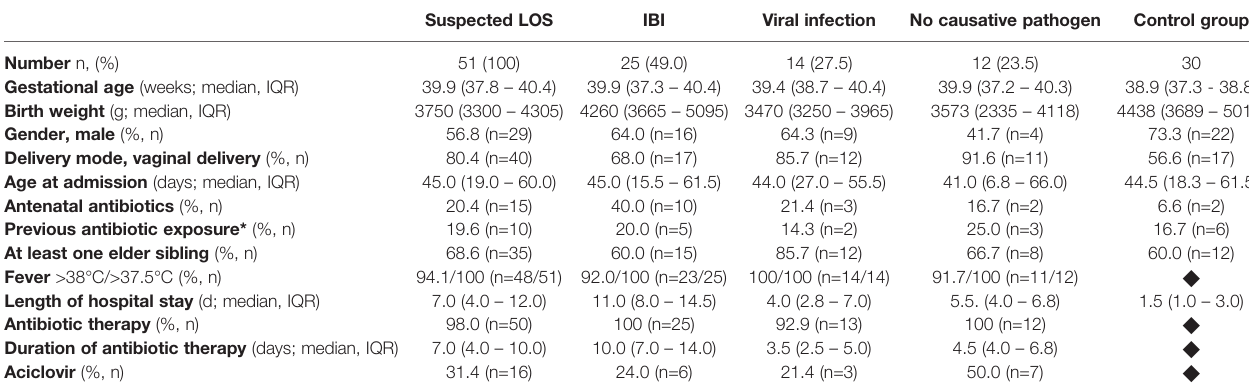
TABLE 1 | Clinical characteristics of study cohort.